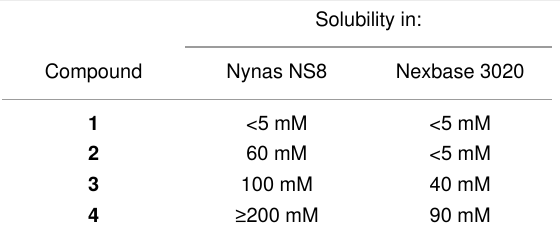
100–700 nm peak at 60 °C/100 °C). Here we assume the forma-